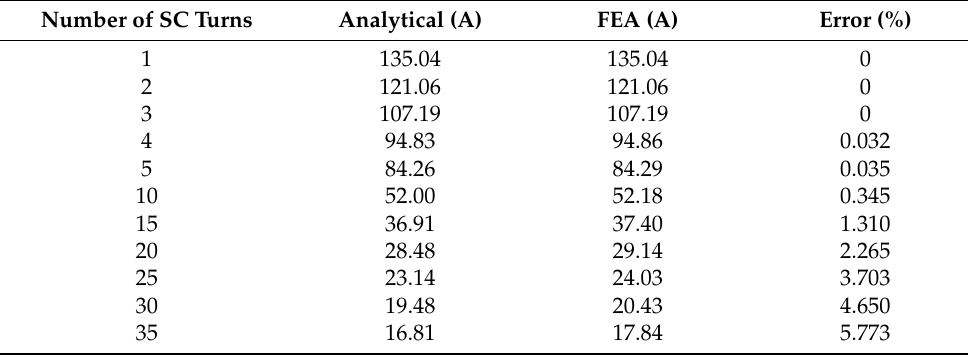
Table 2. Calculation of inter-turn SC